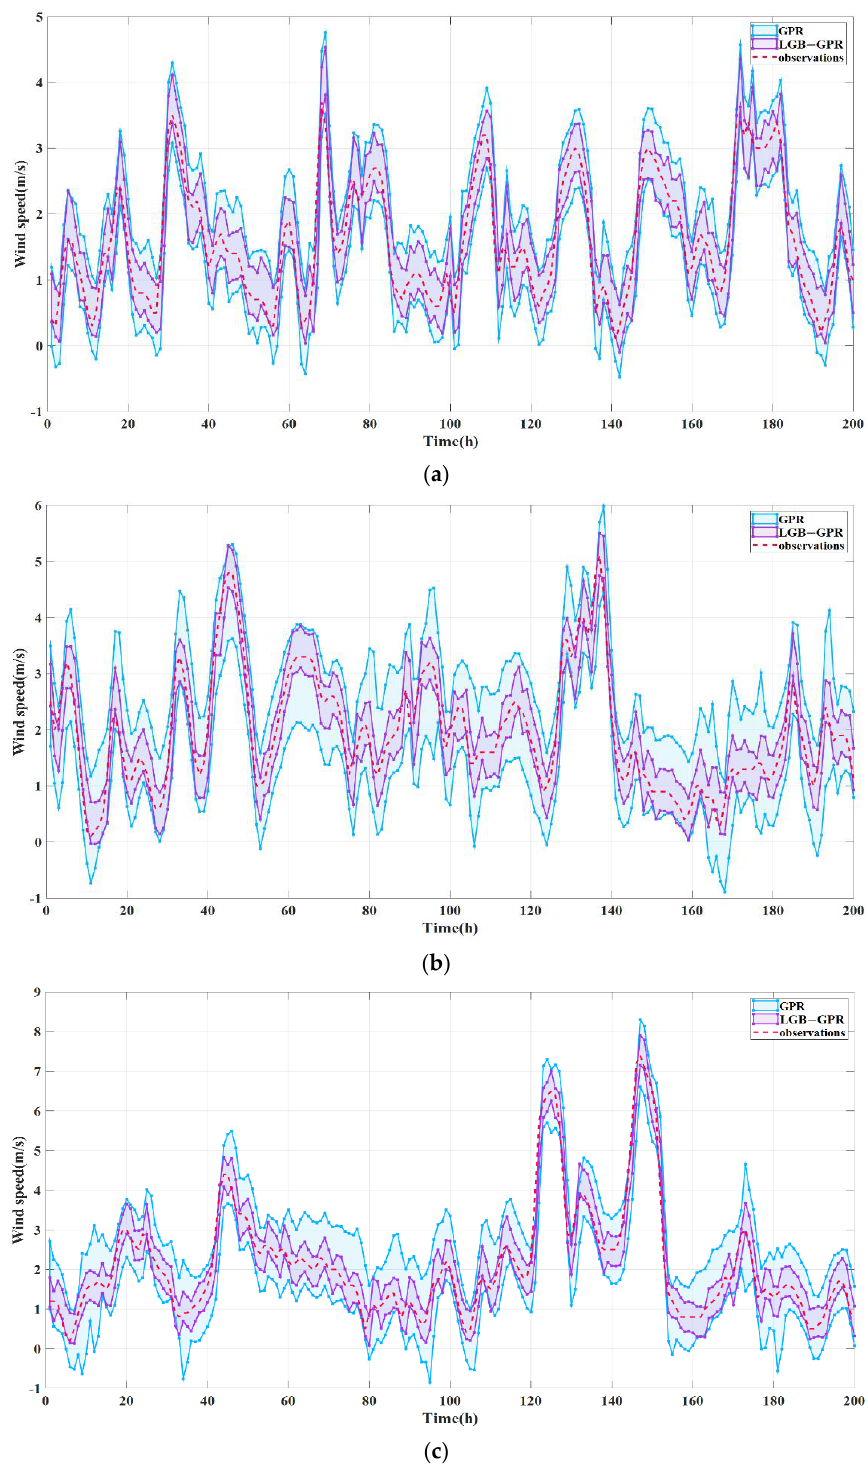
Figure 7. Comparison of probabilistic prediction results in typical time periods: ( a ) Probabilistic prediction results on dataset 1; ( b ) probabilistic prediction results on dataset 2; ( c ) probabilistic prediction results on dataset 3.